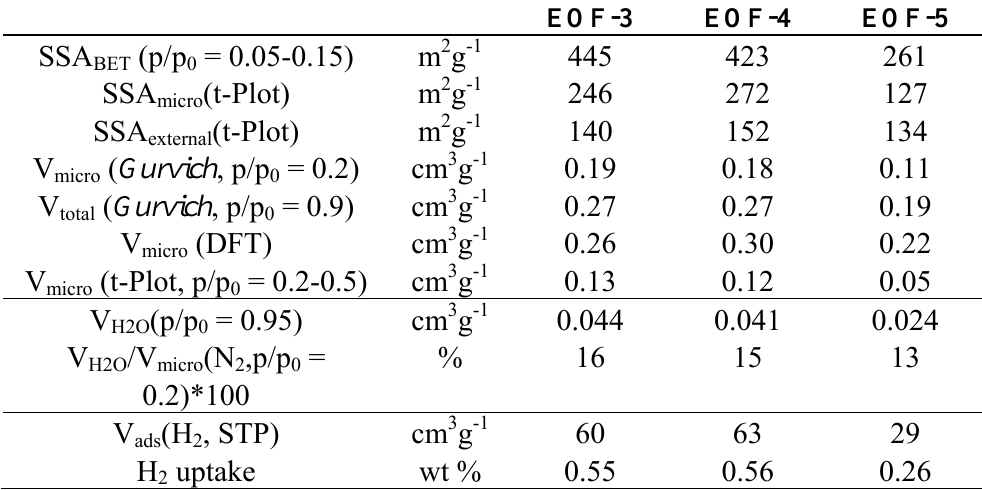
Table 1. Porosity characterization results for EOF-3 to -5.